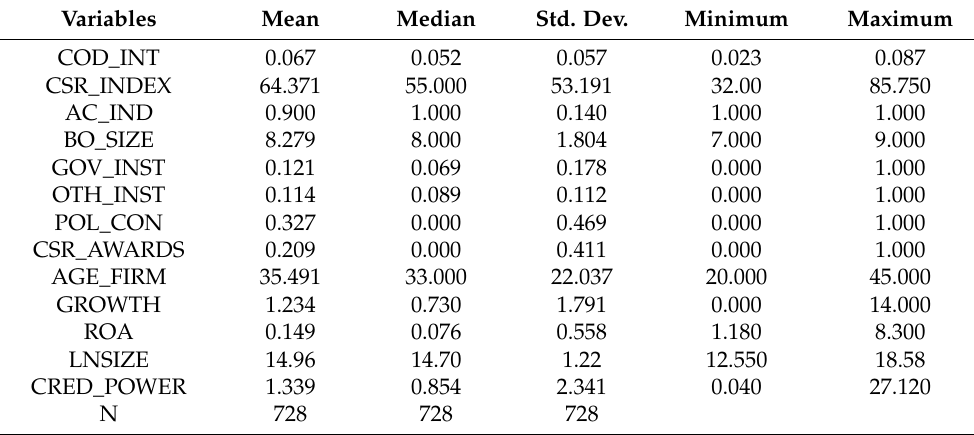
Table 2. Descriptive statistics of dependent and independent variables.